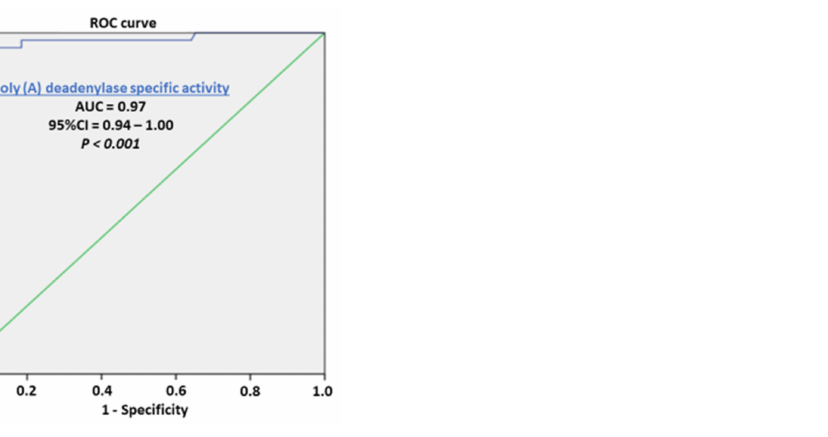
Figure 5. Receiver operating characteristic curve showing the performance of RNASEL-specific expression in predicting prostate cancer.